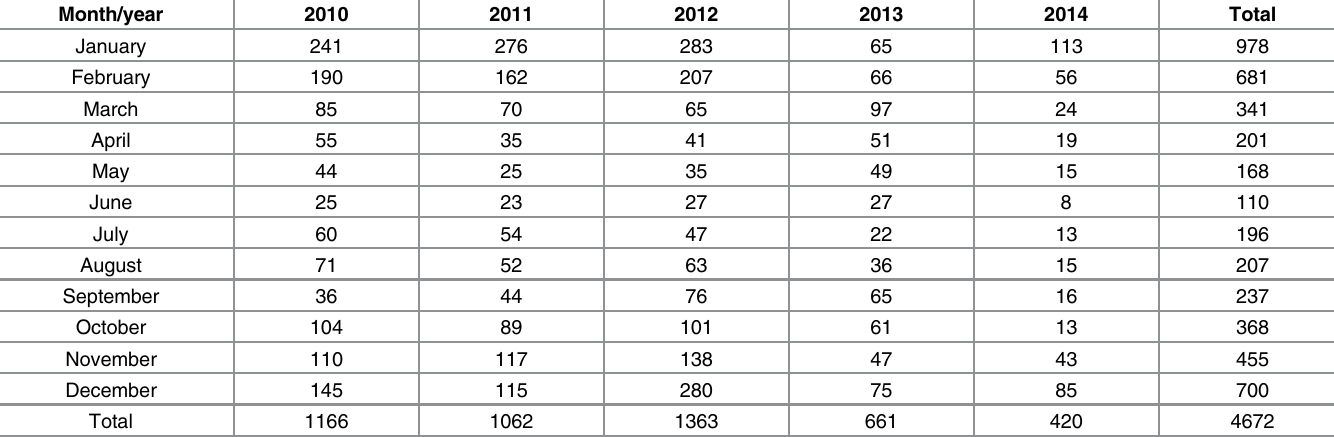
Table 1. The incidence of cutaneous leishmaniasis in Khuzestan Province during the period study.